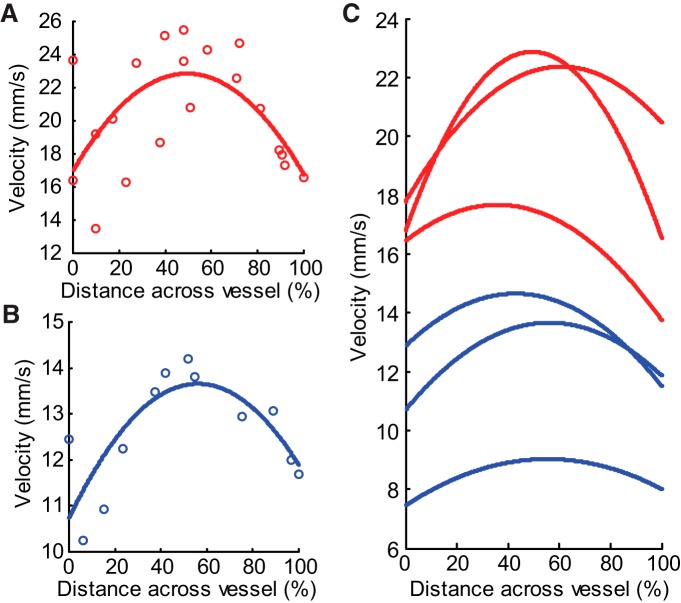
RBC velocity profiles across the width of blood vessels using parallel line scans. A, B, Velocity was determined at many points across the width of an arteriole (A) and a venule (B) by positioning the line scan at different points within the vessel lumen. Velocity was calculated from the slope of fRBC streaks in line scan images (see text for details). Velocity measurements were fit with a second-order polynomial (solid lines). C, Parabolic fits of RBC velocities for individual arterioles (red) and venules (blue).